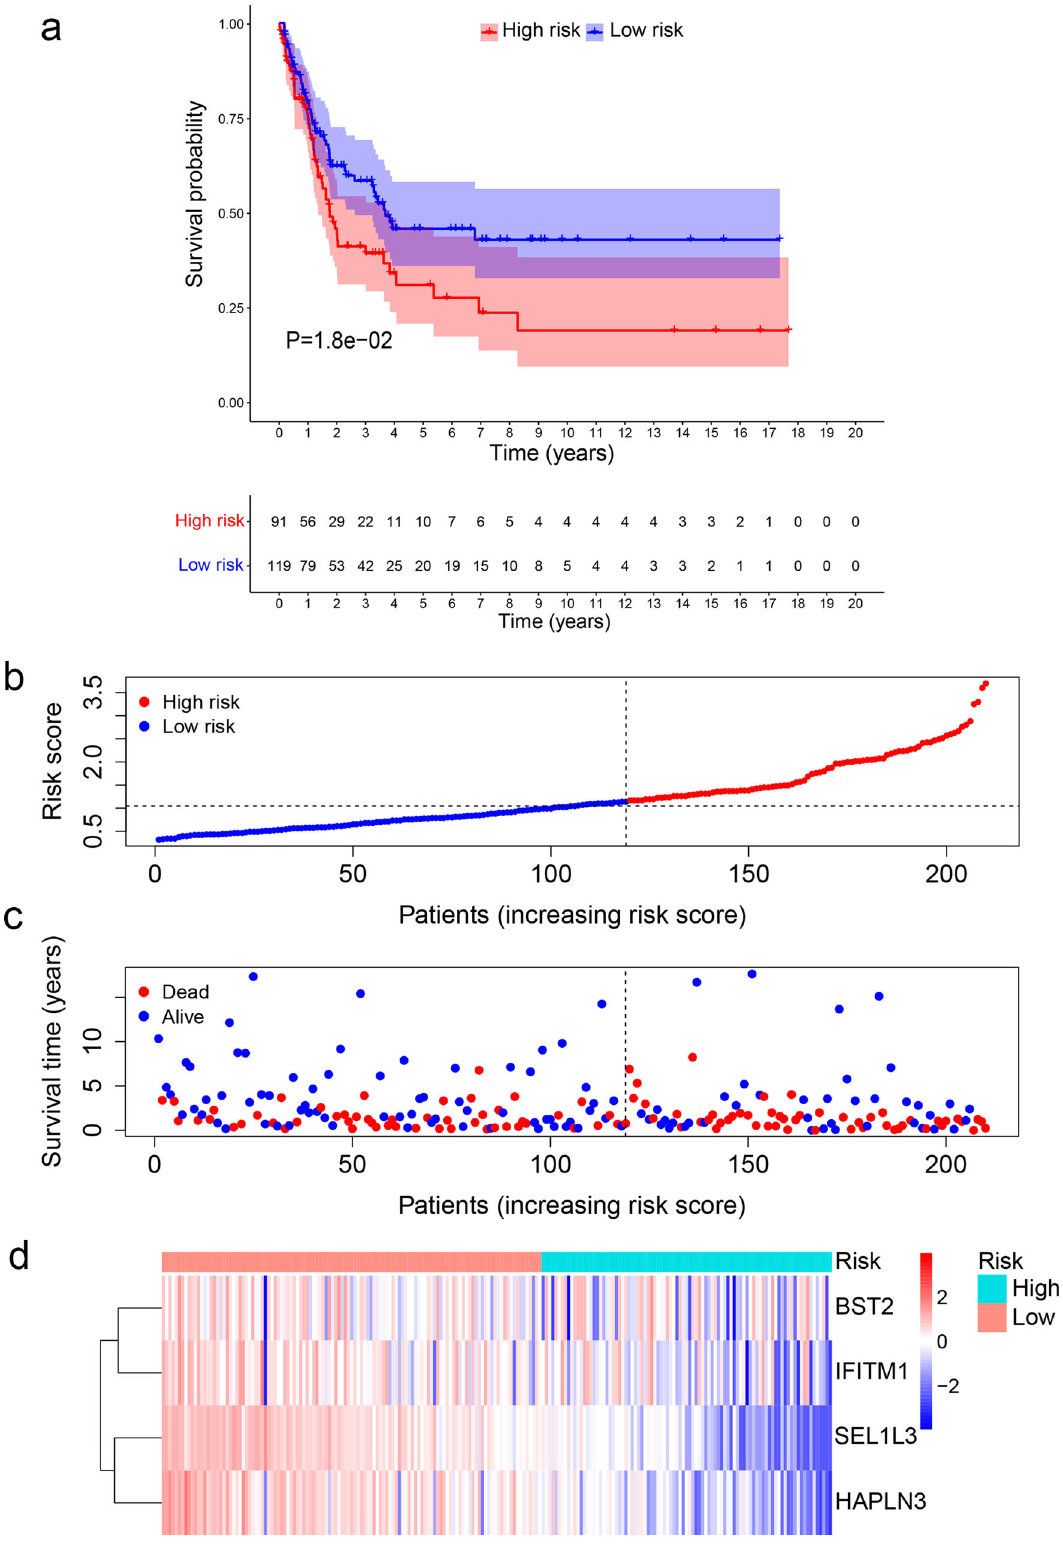
Fig. 3 Validation of the TIR signature for survival prediction in an independent cohort. a Kaplan – Meier curves of the survival rate of patients in the GSE65904 cohort with high TIR risk scores and those with low TIR risk scores. Statistical signi fi cance was determined by the log-rank test. b All patients in the GSE65904 cohort were ranked from the lowest to the highest TIR risk score. c The overall survival time and survival status of individual patients in the GSE65904 cohort. The black dotted line represents the median TIR risk score that divides patients into low-risk and high-risk groups. d Heatmap of SEL1L3 , HAPLN3 , BST2 , and IFITM1 expression levels. Rows represent genes and columns represent patients in the GSE65904